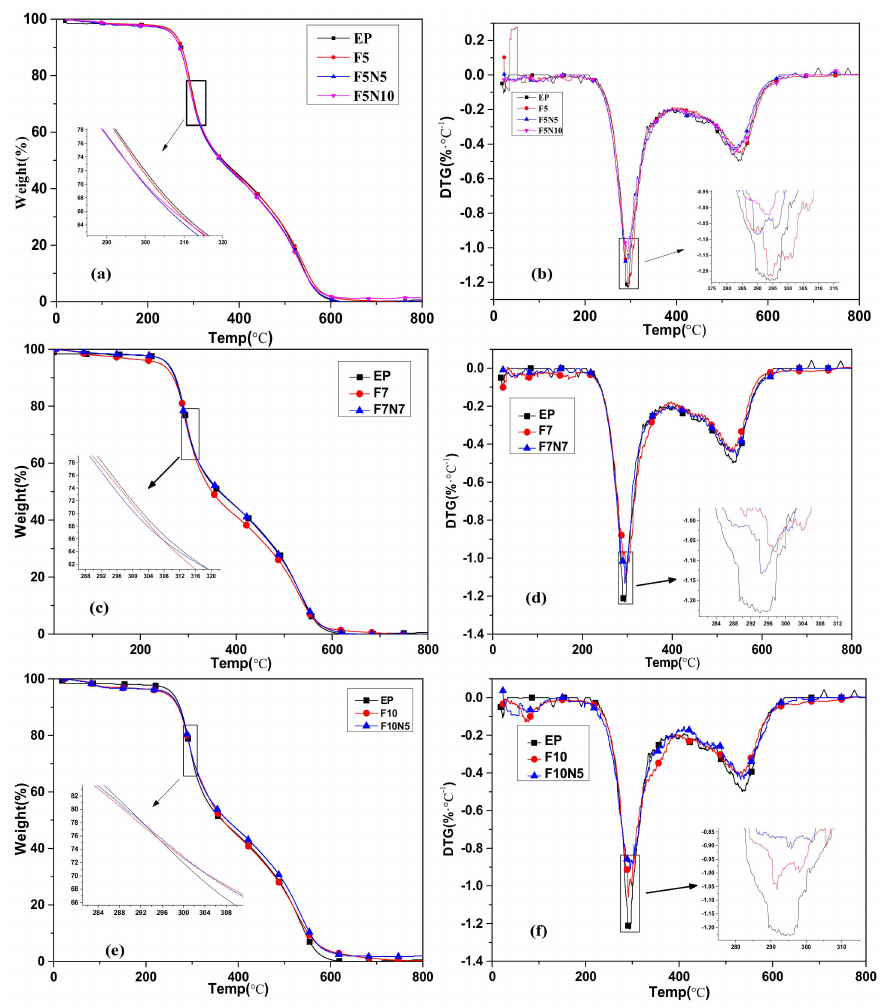
Figure 4. Transition temperature (TG) and DTG curves of CF / EP and CNTs / CF / EP composites. ( a ) TG and ( b ) DTG curves of EP F5 F5N5 F5N10, ( c ) TG, and ( d ) DTG curves of EP F7 F7N7, ( e ) TG and ( f ) DTG curves of EP F10